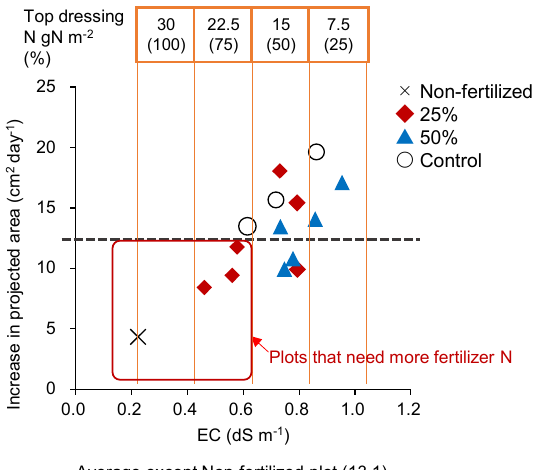
Figure 6. Relationship between EC measured by the CS and increase in the projected leaf area (Trial 3). Values represent the mean of values obtained from five replicates. Increase in the projected leaf area was between 14 and 18 DAT; EC was measured on 14 DAT. Dotted line represents the average except for the non-fertilized plot. Table 3. E ff ects of variable fertilization on the yield of cabbage and nitrogen content (Trial 3). Medi- ans followed by the same le tt er are not signi fi cantly di ff erent according to the Kruskal–Wallis test. n.s. indicates no signi fi cance at p < 0.05.